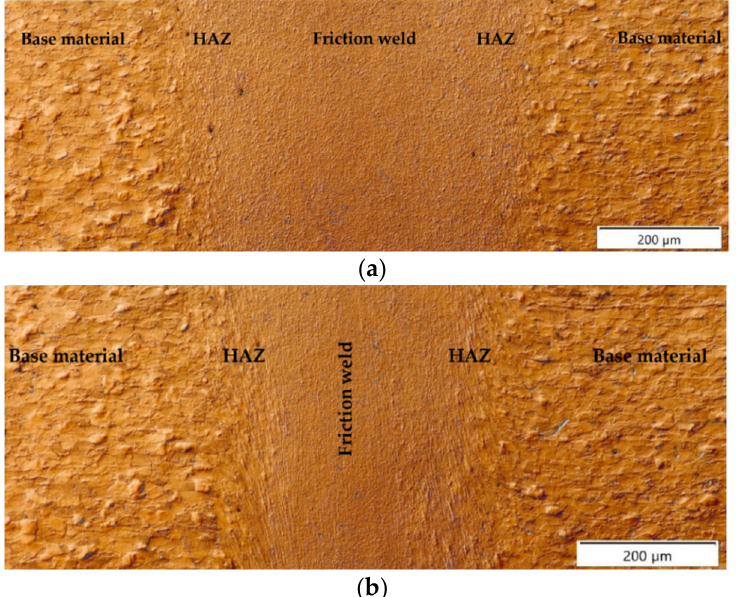
Figure 4. Microstructure of a high-speed friction welded joint with p f = 191 MPa made: ( a ) on the radius, ( b ) at the axis, (optical observations with DIC).